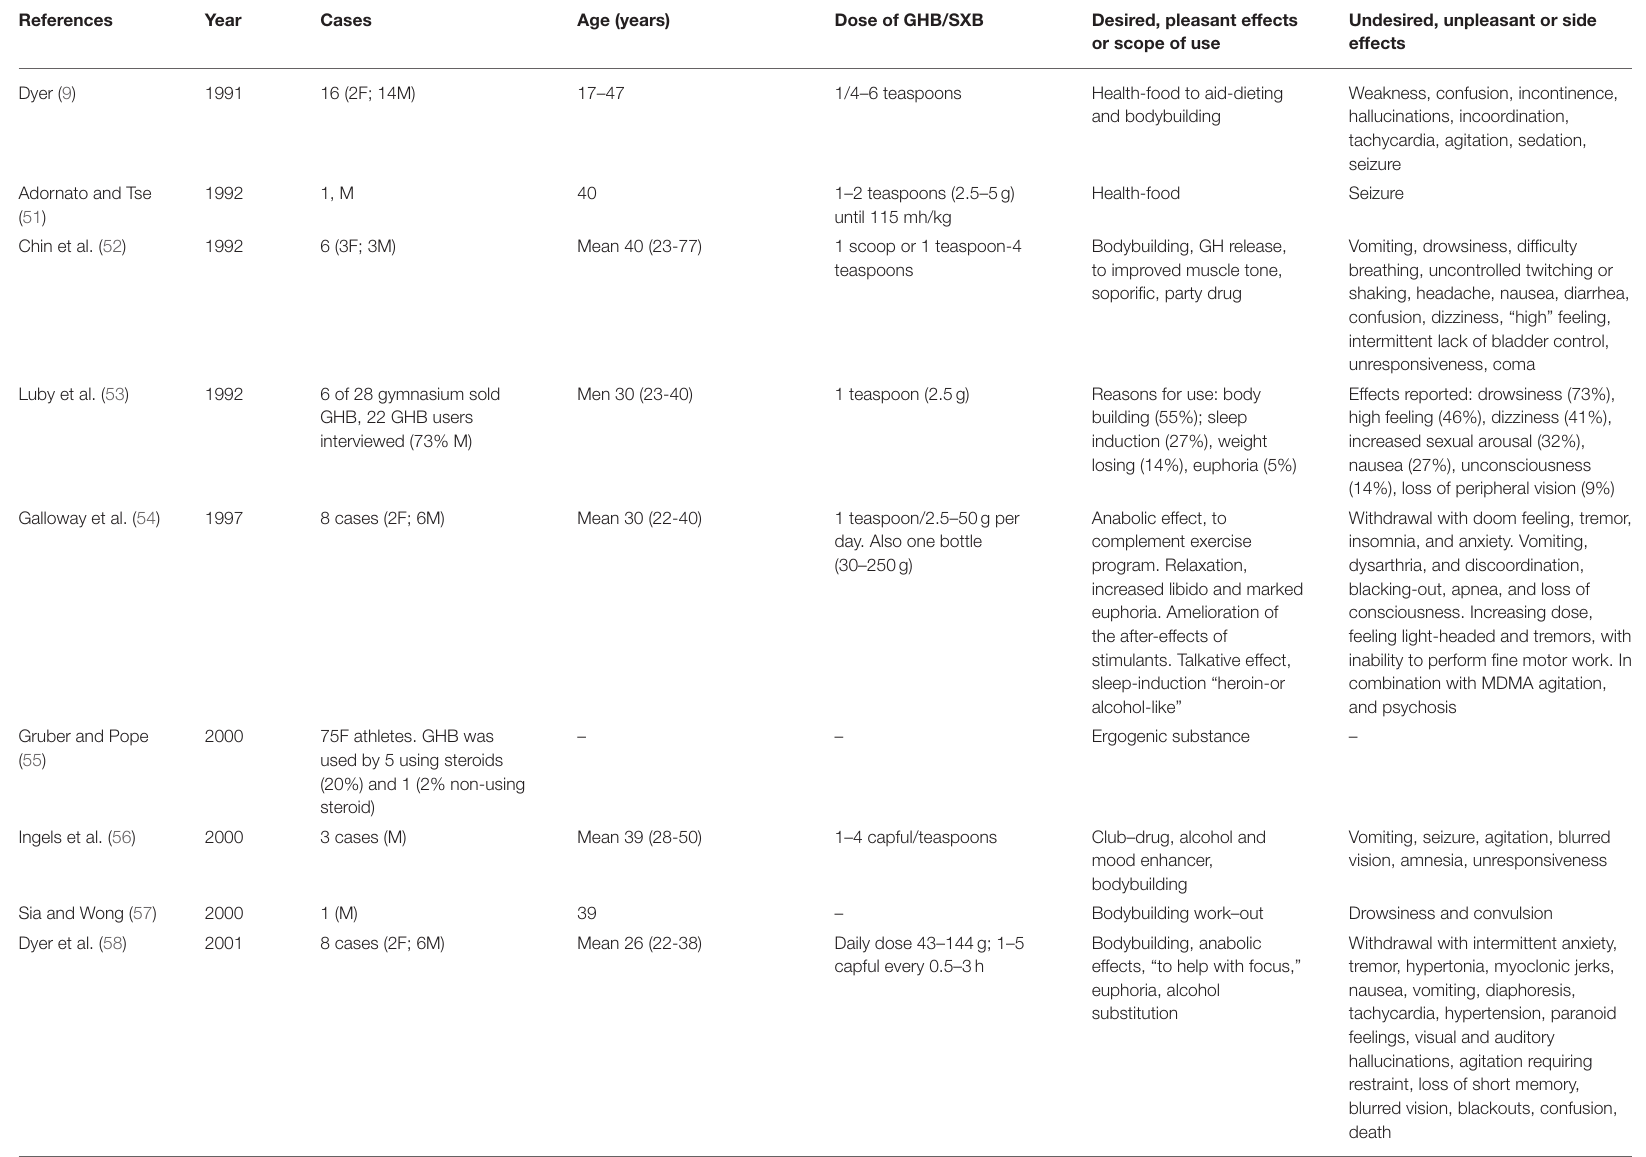
TABLE 2 | Epidemiological and real-case